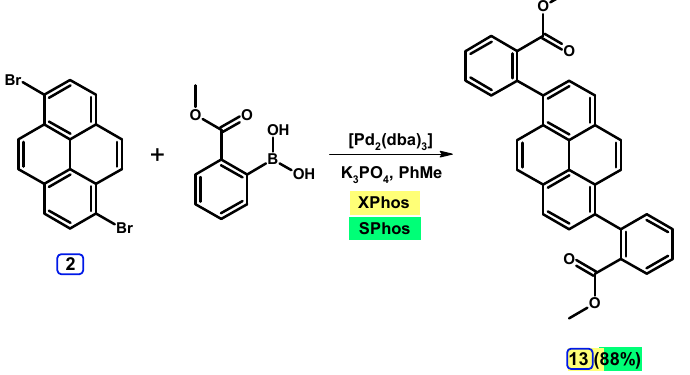
Scheme 9. Introduction of anthracen-9-yl motifs into pyrene structure by using the Suzuki-Miyaura coupling reaction